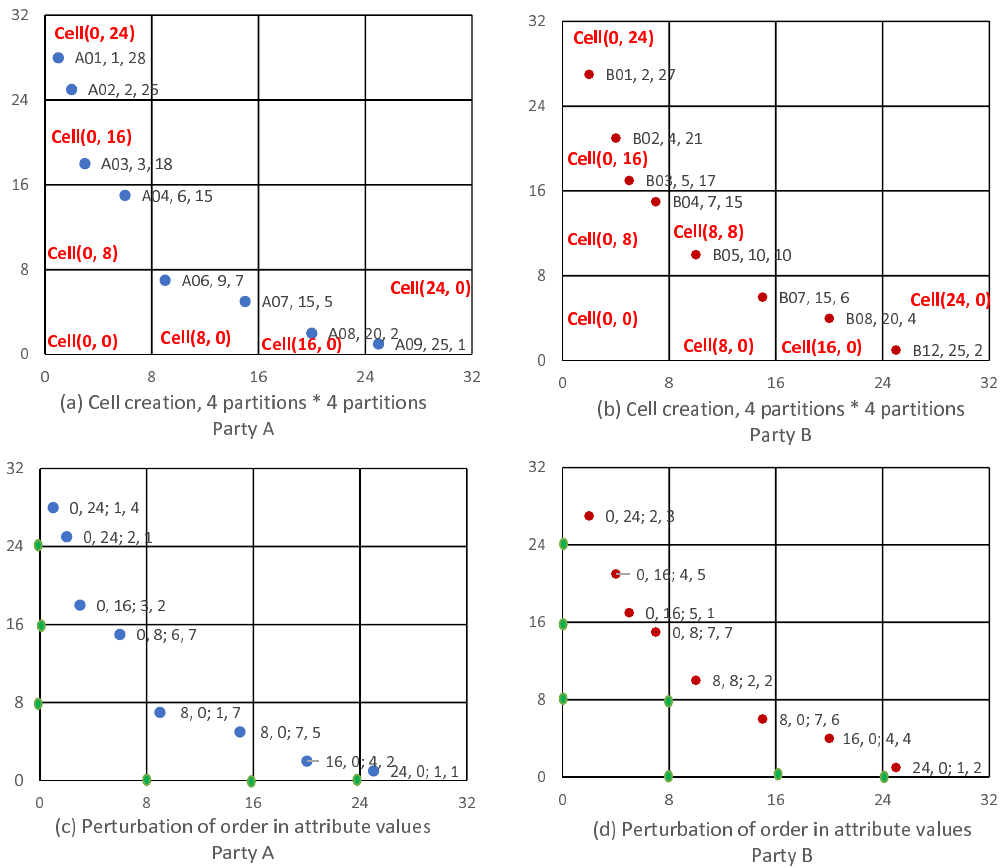
Figure 4. Cell creation and attribute value perturbation of objects in the local skyline of Party A and Party